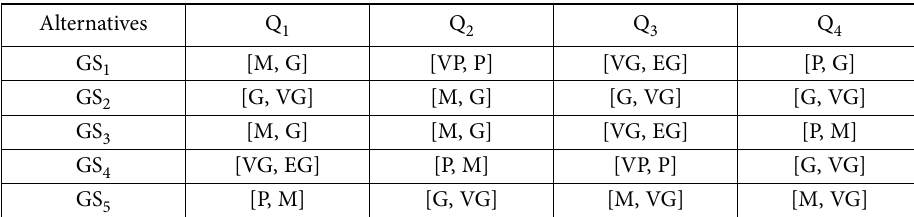
Table 7. The ULTSs through DM